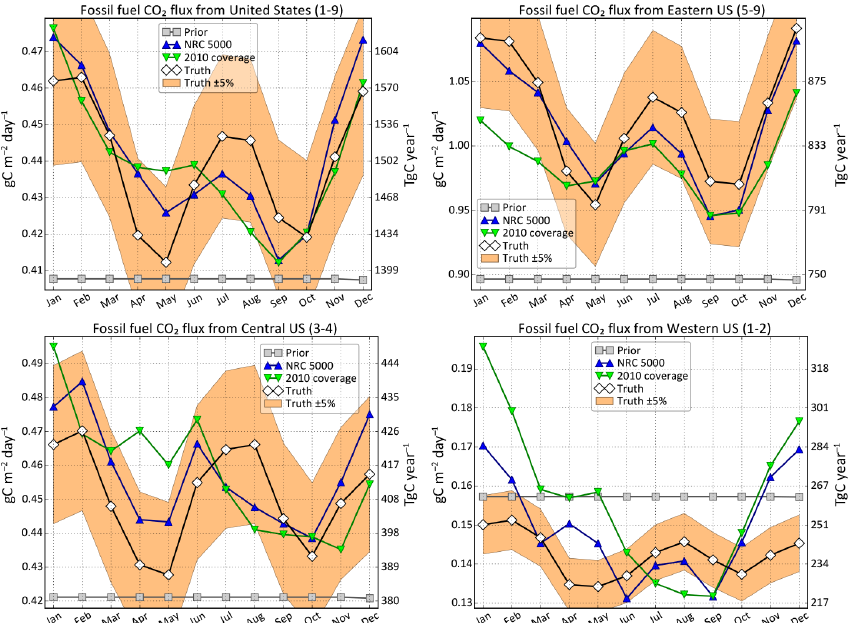
Figure 6. Monthly total emissions estimates for 2010 and NRC 5000 network scenarios, along with prior and true fluxes, aggregated for the conterminous US and neighboring groups of regions identified in Fig. 5. The orange band depicts the ± 5% margin around the true fluxes, and the numbers next to region names refer to the region labels in Fig.